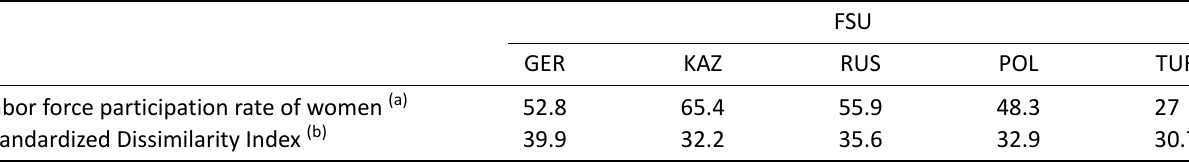
Table 1. Gender‐related labor market characteristics by country of